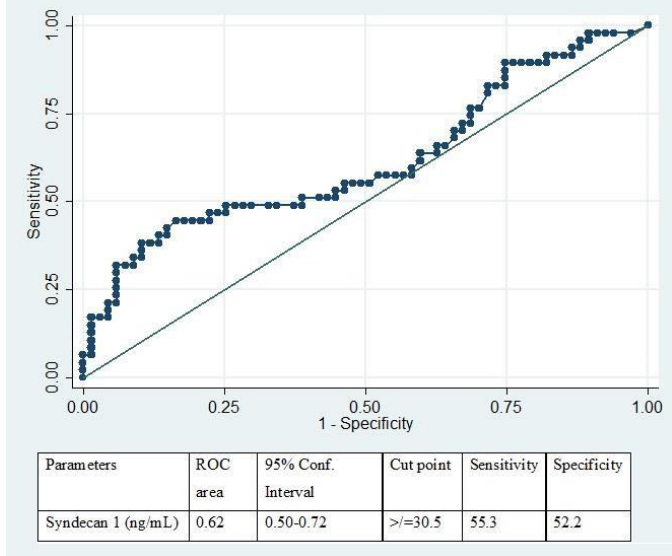
Figure 3. Receiver operating characteristic (ROC) curve analysis to establish a clinical cut-off of plasma syndecan-1 levels to identify TBI-associated coagulopathy. Table 3. Glycocalyx shedding and endothelial